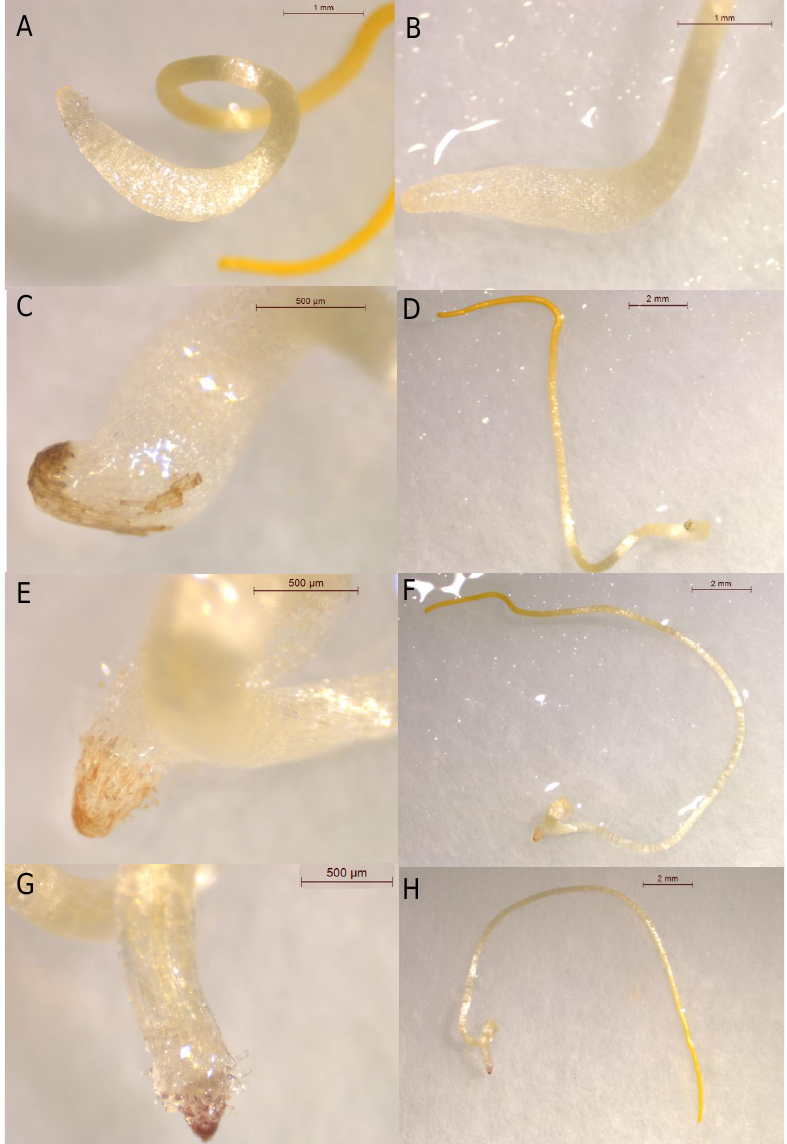
Figure 4. Photographs showing C. campestris root apices ( A – C , E and G ) and whole seedlings ( D , F and H ) treated with ( A ) a control or 1 mM treatments of ( B ) trans -cinnamic acid ( 1 ), ( C and D ) trans - caffeic acid ( 9 ), ( E and F ) trans -ferulic acid ( 10 ), and ( G and H ) trans -sinapic acid ( 11 ).